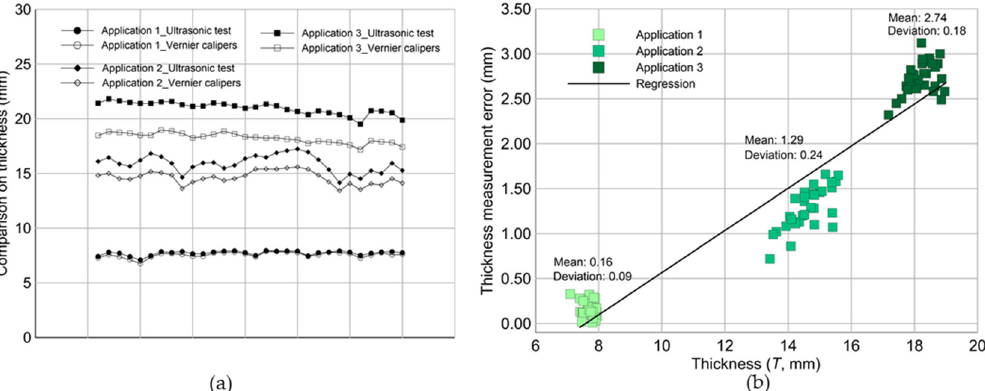
Figure 4. ( a ). Comparison of actual thickness and thickness determined using ultrasonic testing for each hull plate prototype, and ( b ) comparison of measured thickness errors as a function of the hull plate prototype thickness.